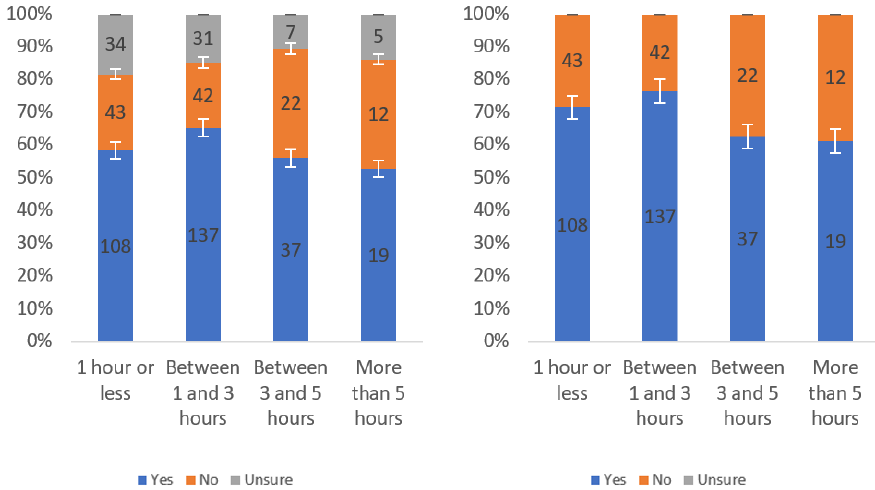
Figure 21. Responses regarding usefulness in judging trustworthiness by internet usage level in- cluding ( left ) and excluding ( right ) unsure responses. ing ( left ) and excluding ( right ) unsure